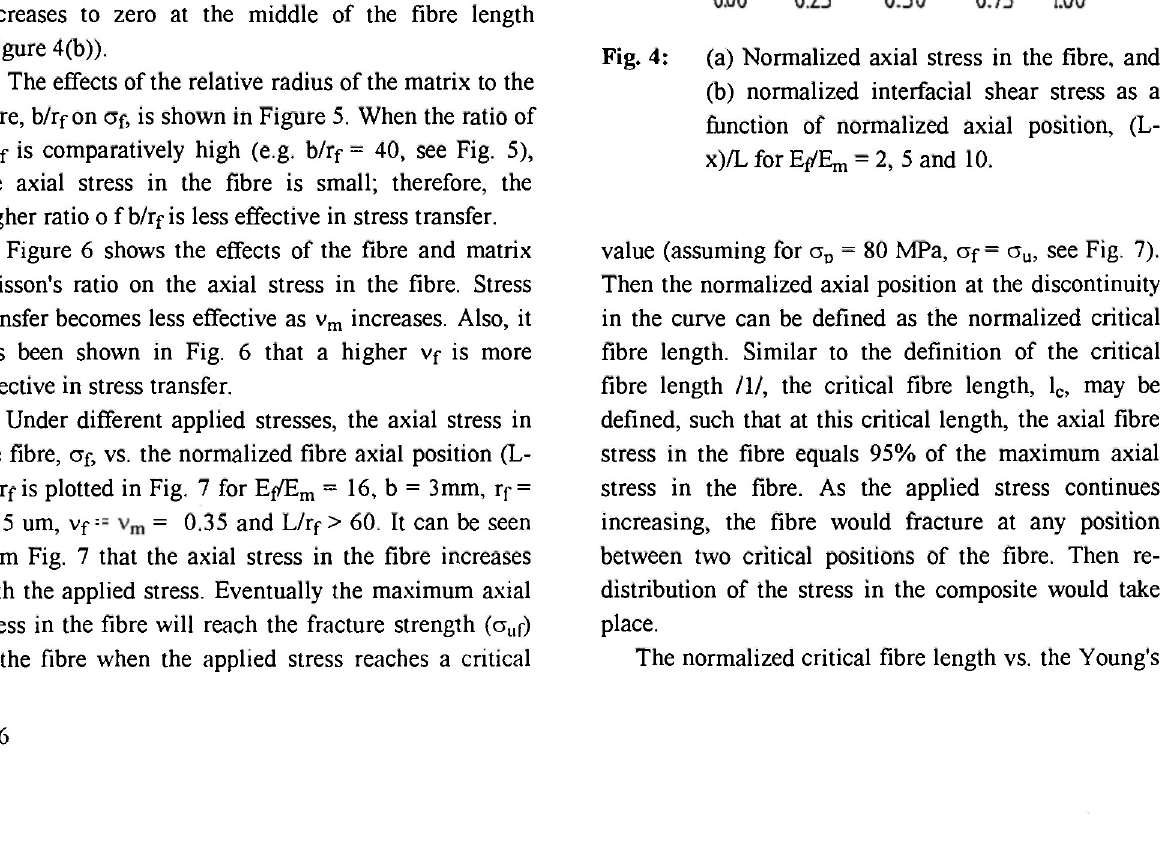
Fig. 4: (a) Normalized axial stress in the fibre, and (b) normalized interfacial shear stress as a function of normalized axial position, (L- x)/L for Ef/Em = 2, 5 and